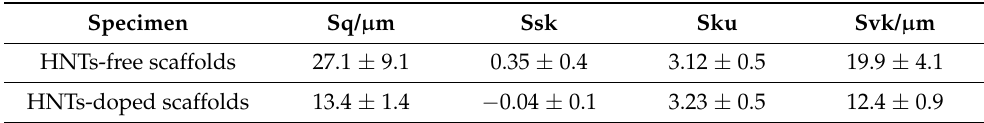
Figure 2. Surface topography of 3D porous scaffold visualization in different modes. ( A – D )—scaffold without HNTs, ( A )—height mode, ( B )—laser intensity mode, ( C )—optical micrograph, ( D )—3D height rendering mode; ( E – H )—scaffold doped with HNTs, ( E )—height mode, ( F )—laser intensity mode, ( G )—optical micrograph, ( H )—3D height rendering mode. Table 1. Roughness parameters in polymer scaffolds as measured using 3D confocal laser scan- ning